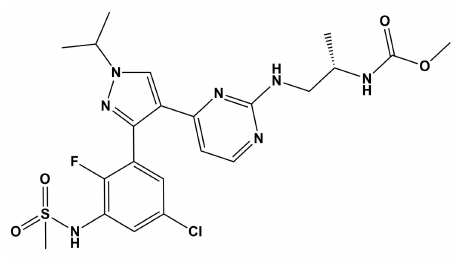
Figure 1. Chemical structure of